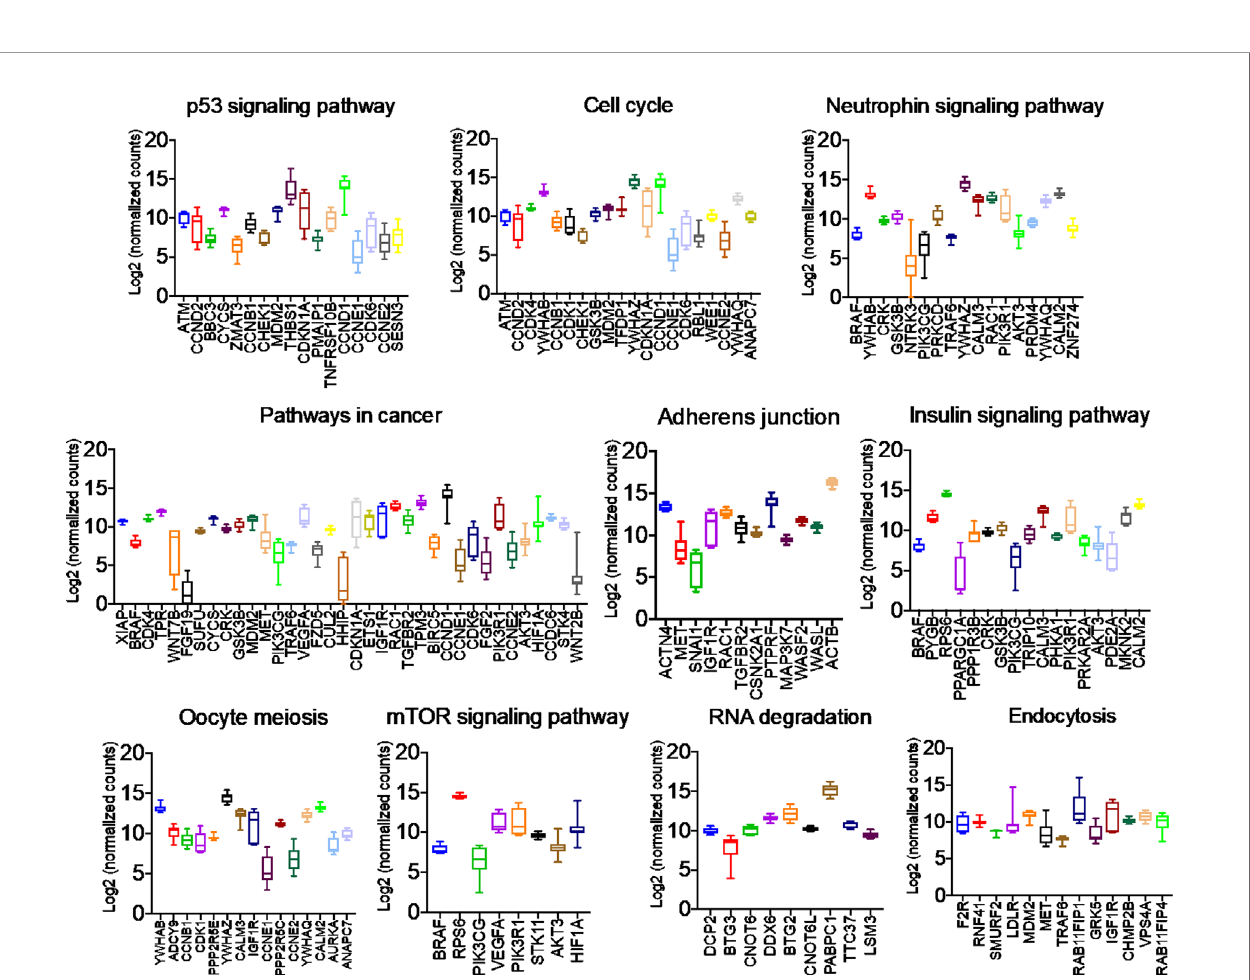
FIGURE 4 | Network analysis identi fi ed miRNA target genes to be upregulated in breast cancers following AG-205 treatment. miRNAs target differentially expressed genes miRNA target genes that are upregulated in metastatic breast tumor samples. A Log2 (normalized_counts) expression of upregulated miRNA target genes in metastatic breast tumor samples downloaded from TCGA database. miRNA target genes are involved in term pathways identi fi ed by KEGG analysis and are direct targets of the top